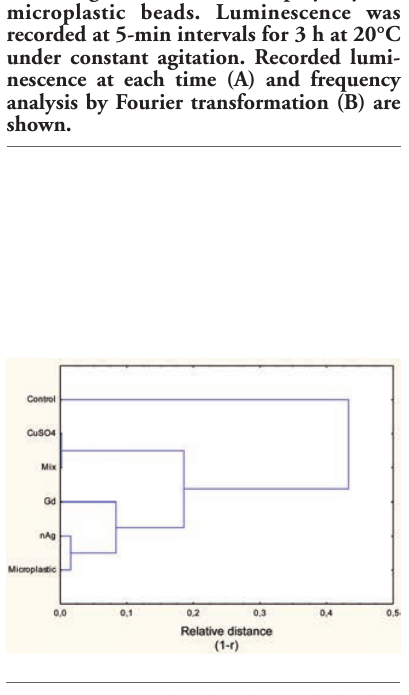
Figure 6. Hierarchical analyses of the first eight frequencies in luminescence changes. The periodogram value of the first eight frequencies was used to classify the quo- rum-sensing properties of the selected con- taminants in bacterial suspension. Mixture was composed of the lowest concentration of CuSO (75 µM), GdCl3 (30 µM), nAg 4 (20 µg/L) and microplastic beads (1